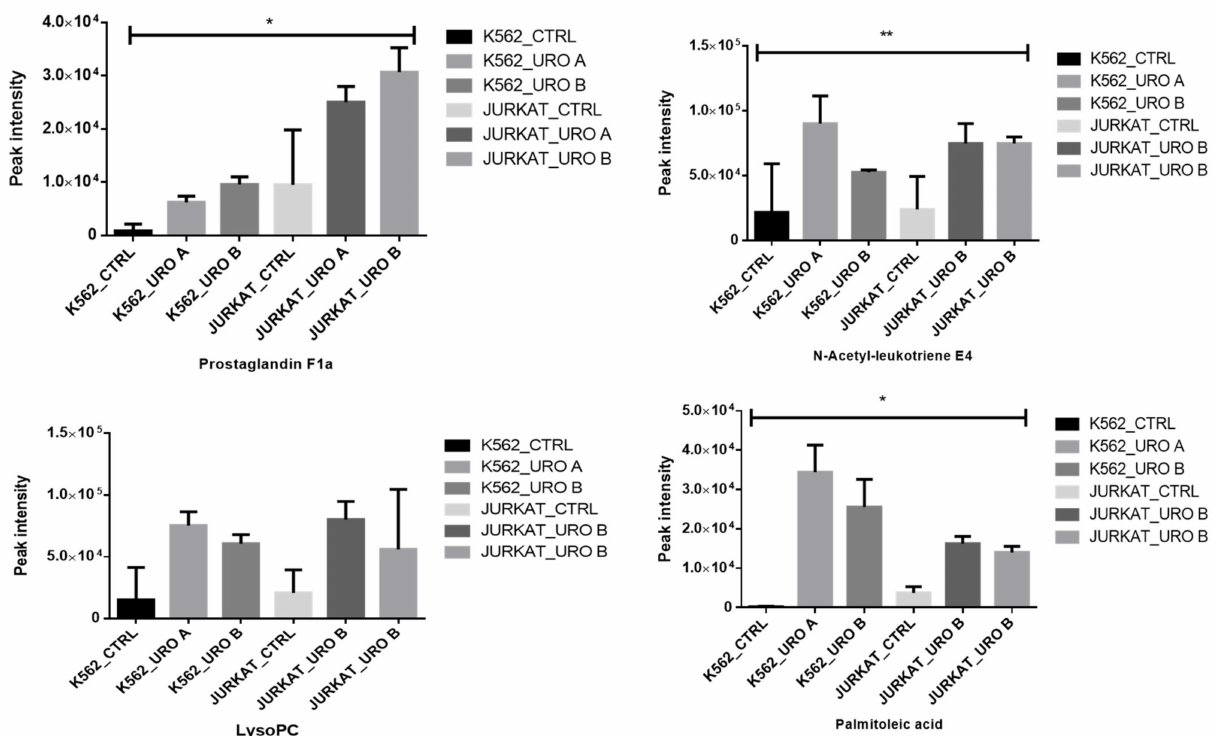
Figure 6. Urolithin A and B both alter various metabolites associated with different lipid pathways in leukemic cells. Data presented here for both control and urolithin A- and urolithin B-treated cells, * p < 0.01. ** p <